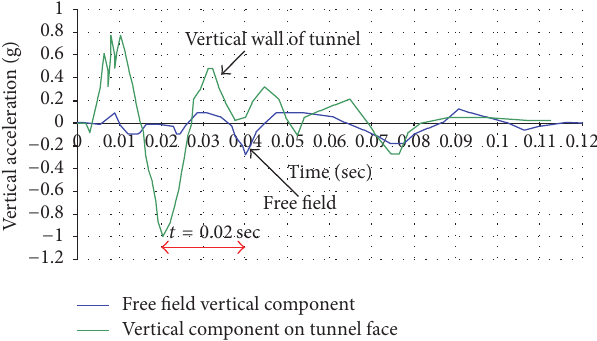
Figure 8: The comparison of vertical accelerations between vertical wall of tunnel and free